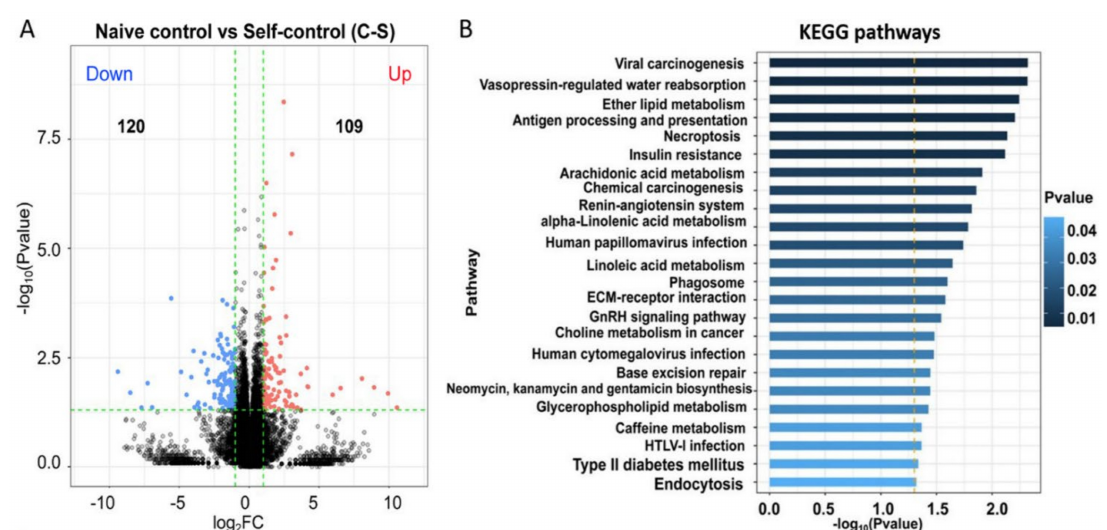
Figure A1. Transcriptional profiling of retinas from self-control eyes of FDM guinea pigs. ( A ) Volcano plot showing highlights of differentially expressed genes (DEGs) from bulk RNA sequencing of naïve control and self-control retinas. ( B ) The significantly enriched pathways in the self-control retina (compared to naïve control retina) from the KEGG analysis of the